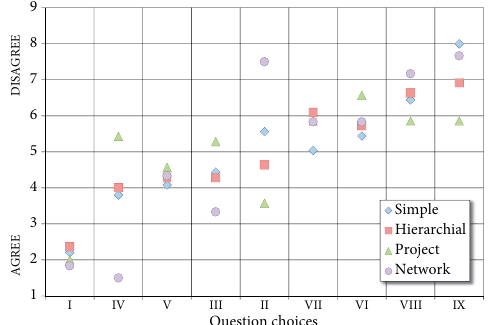
Fig. 3. Marketing perspectives of companies according to their organizational